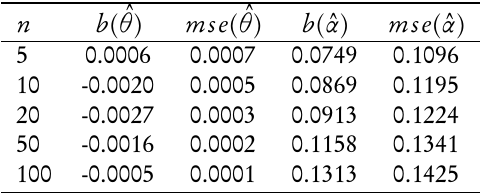
θ = 0.75 , m = 20 , and α = 7.80 .